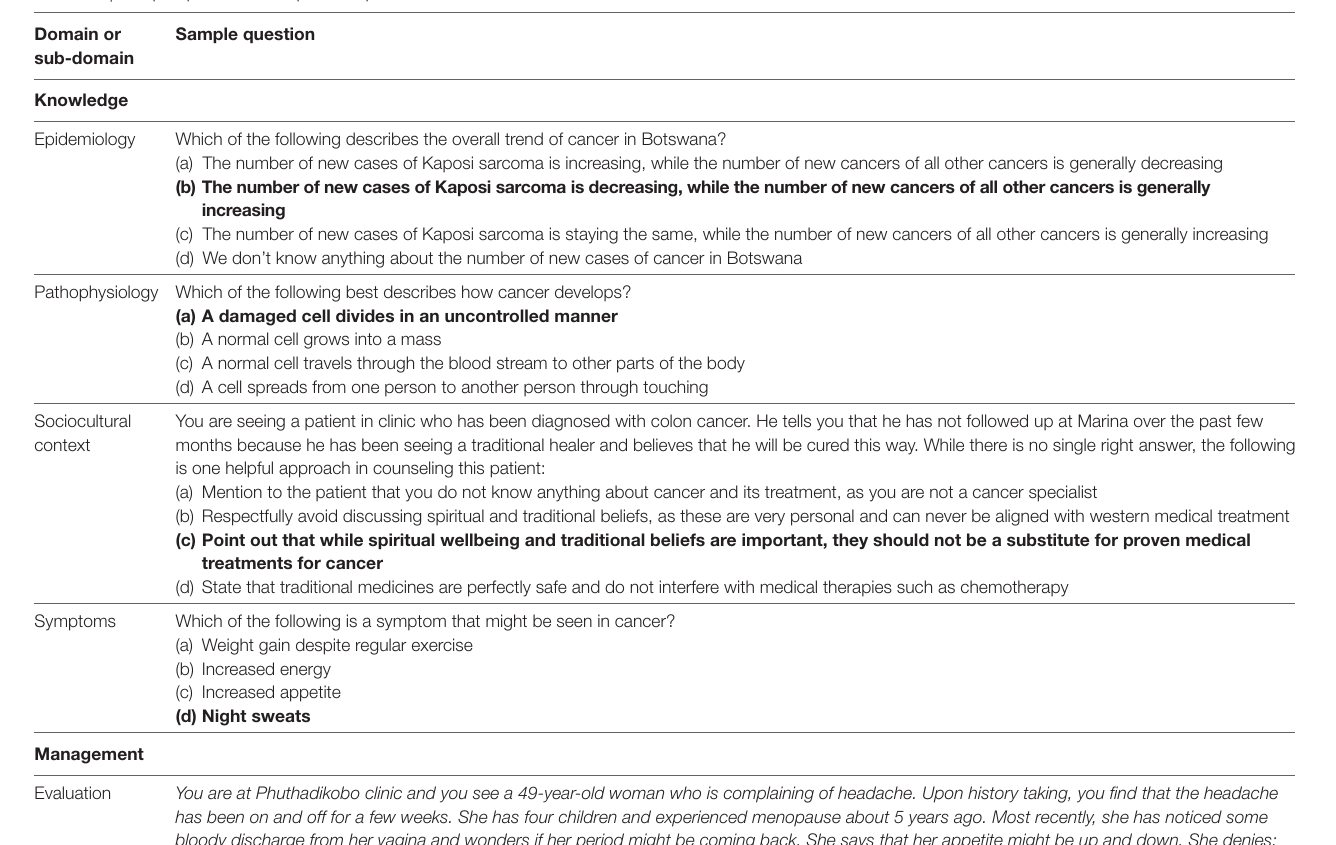
TaBle 1 | Sample questions from pre- and